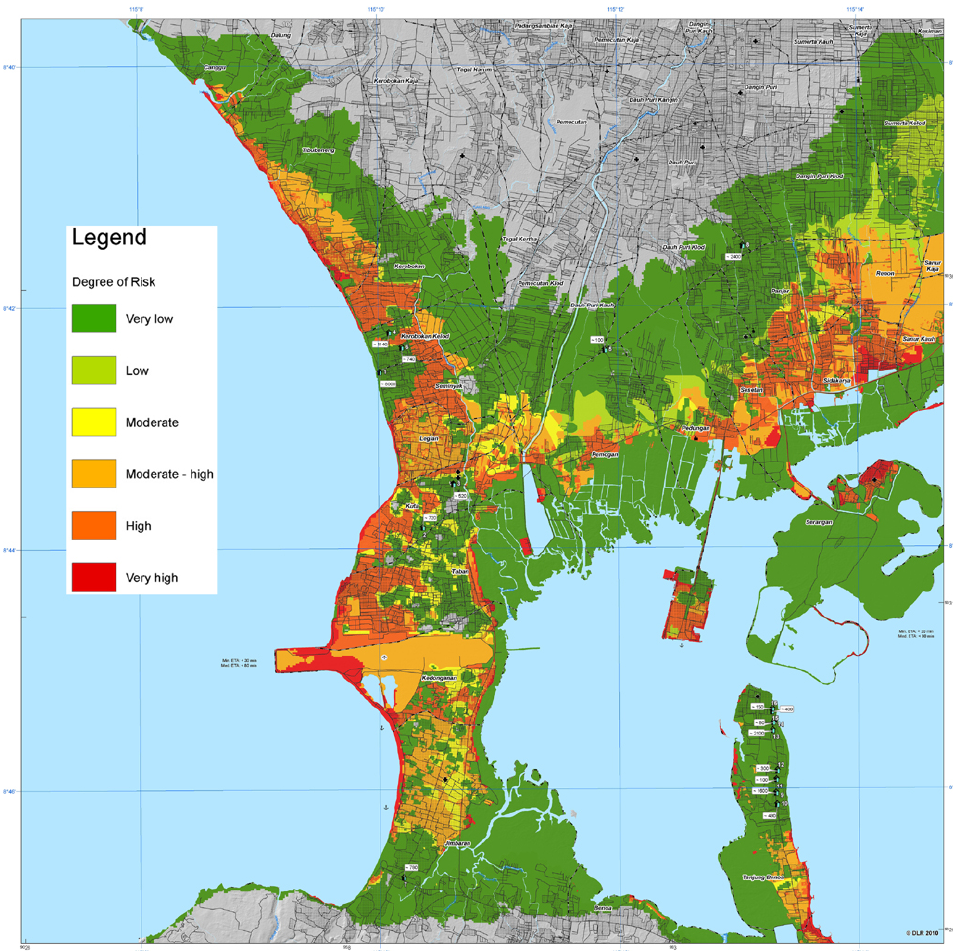
Fig. 13. Risk map of Kuta (Bali) highlighting the areas (in red) with high needs for tsunami evacuation